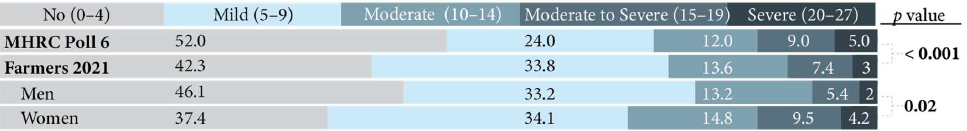
Figure 2. Classification of no, mild, moderate, moderate to severe, and severe depressive disorder symptoms for overall 2021 sample and by gender, in comparison to the Canadian general population during COVID-19 from Mental Health Research Canada’s (MHRC) Mental Health During COVID-19 Outbreak poll 6.